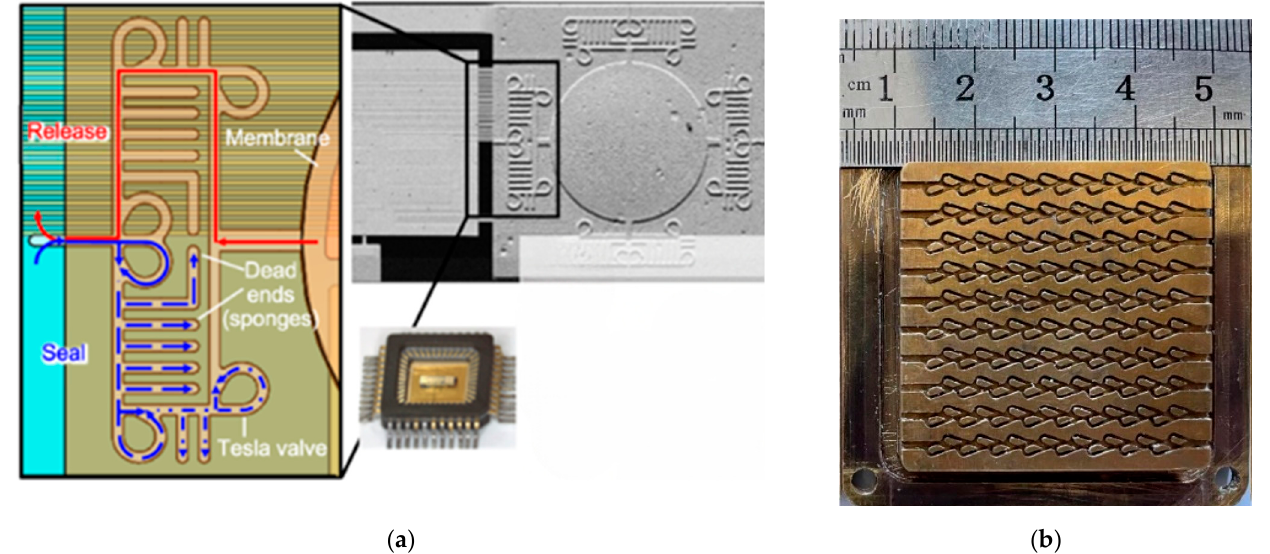
Figure 7. The ( a ) TV microchannel for release and sealing management in capacitive sensor protection. Reprinted from [62] under Creative Commons license. ( b ) The high throughout TV microfluidics for flow boiling system in electronic devices. Reprinted with permission from [57] copyright © 2023 Elsevier.